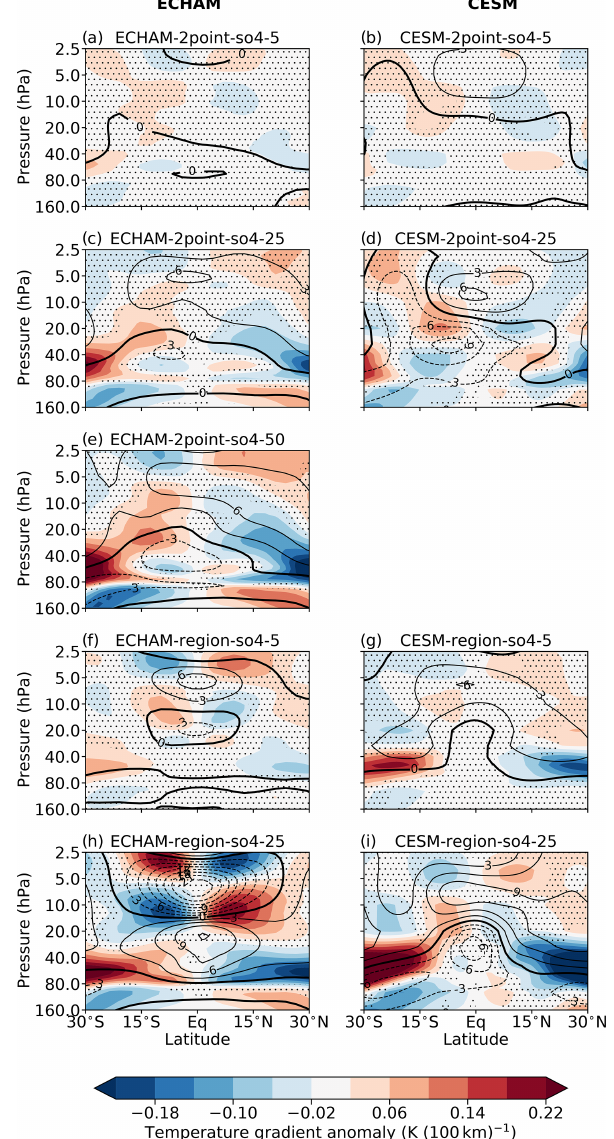
Figure 13. Latitude–height cross sections of the anomaly of the meridional zonal mean temperature gradient T y for the AM − SO 4 injection scenarios in ECHAM (left column) and in CESM (right column). Stippling indicates areas where anomalies are not signifi- cant at the 95% level in Student’s t test. Black contour lines indicate the anomaly of the zonal mean zonal wind speed u in intervals of 3ms − 1 , with the thick black line denoting u = 0ms − 1 . Solid lines denote a westerly anomaly, while dashed lines denote an easterly anomaly. The first row shows the 2point injections of 5Tg ( S ) yr − 1 , the second row shows the 2point injections of 25Tg ( S ) yr − 1 , the fourth row shows the region injections of 5Tg ( S ) yr − 1 , and the fifth row shows the region injections of 25Tg ( S ) yr − 1 . The 2point in- jection of 50Tg ( S ) yr − 1 was only performed with ECHAM and is shown in the third